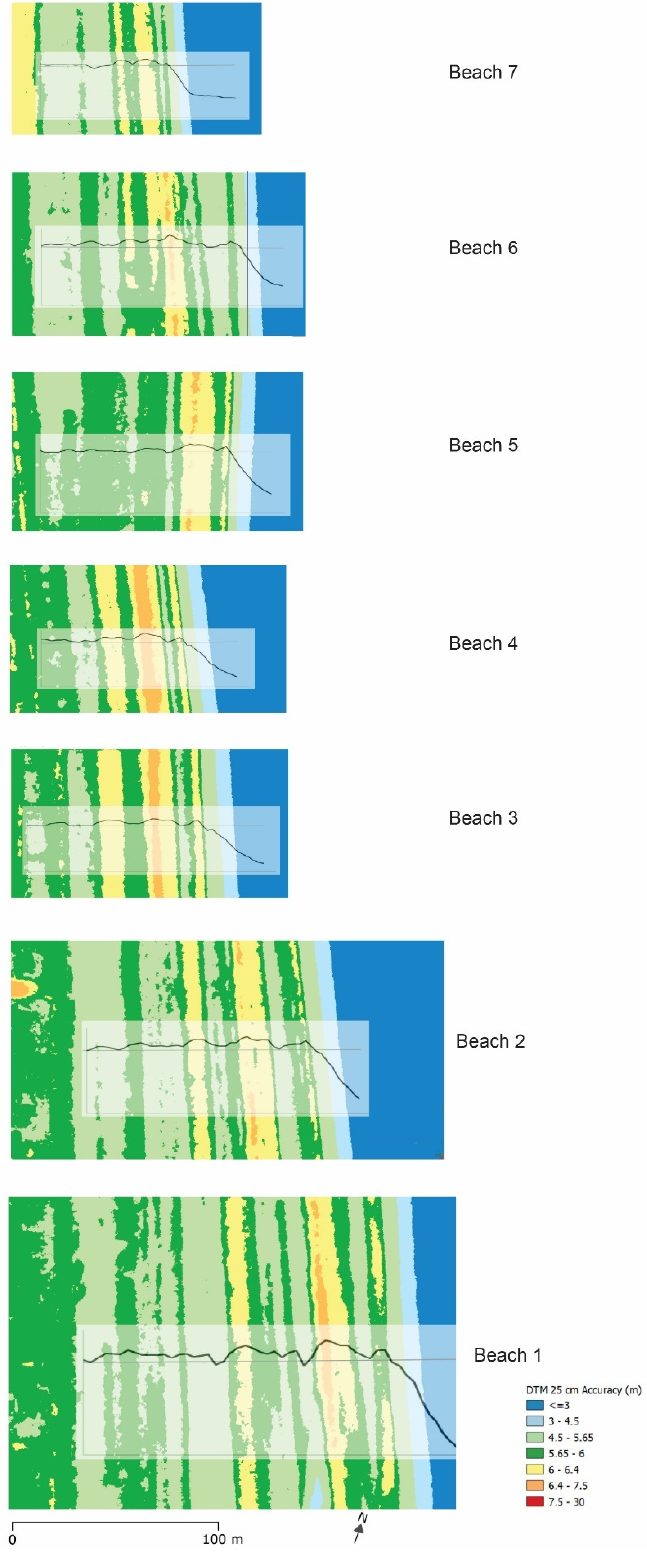
Figure 4. The number of beach ridges depicted in dark green, yellow, and orange decreases from south to north along the coast. Elevation maps compiled from 25 cm Lidar data with the location of the GPR survey lines Beach 1–7, see Figures 1 and 3 for locations.